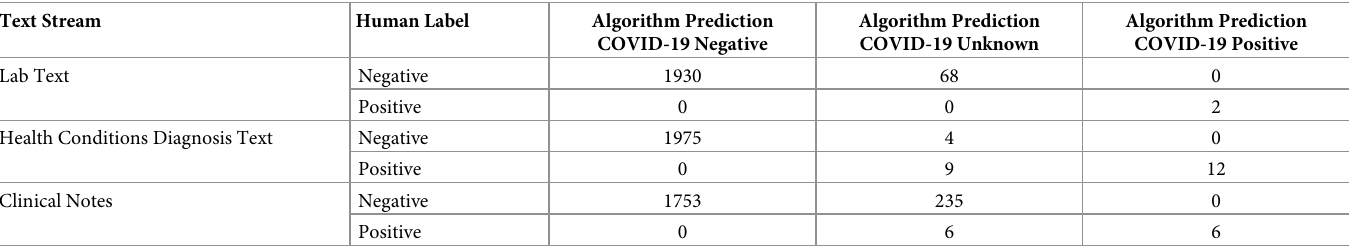
Table 4. Internal validation of the COVID-19 biosurveillance system (comparing human labelled document classifications versus algorithm derived document clas- sifications) when applied to the following primary care text streams: lab text, health condition diagnosis text, and clinical notes. Text